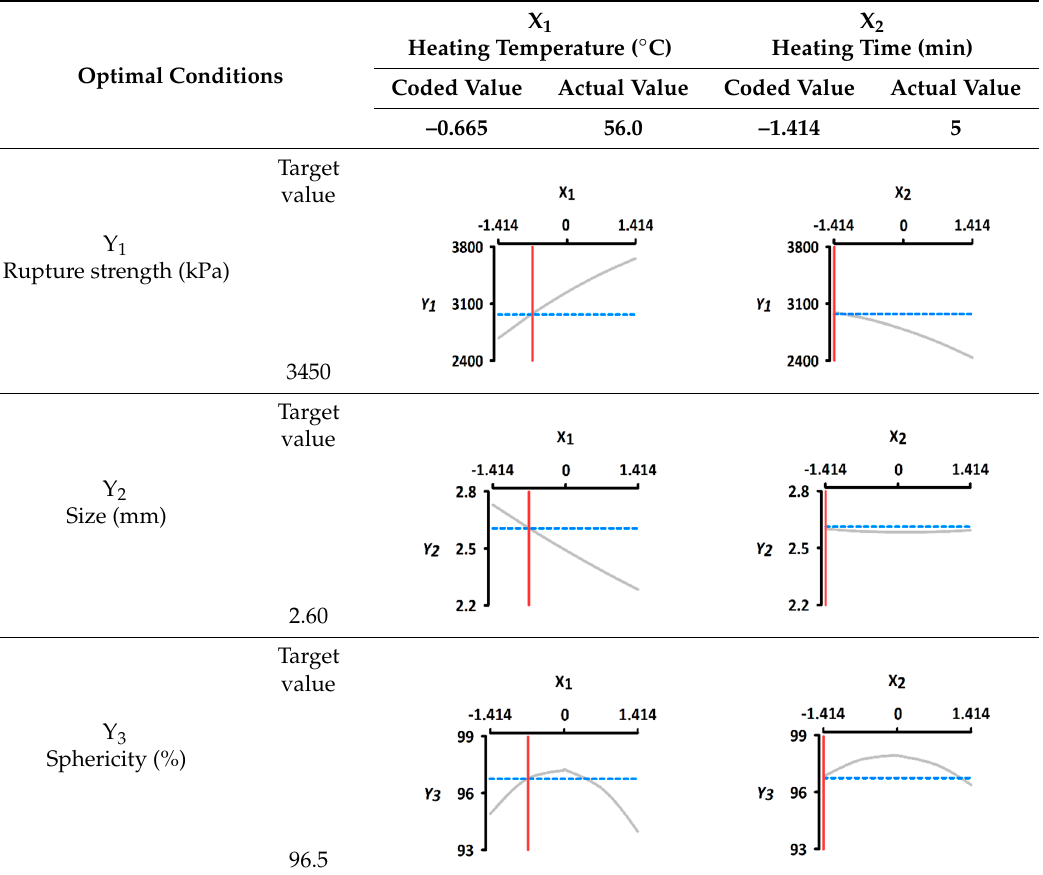
Table 7. The rupture strength, size, and sphericity of before heat treatment CAG beads. Table 8. Response optimization for processing a heated CAG beads similar result to non-heated CAG beads conditions.